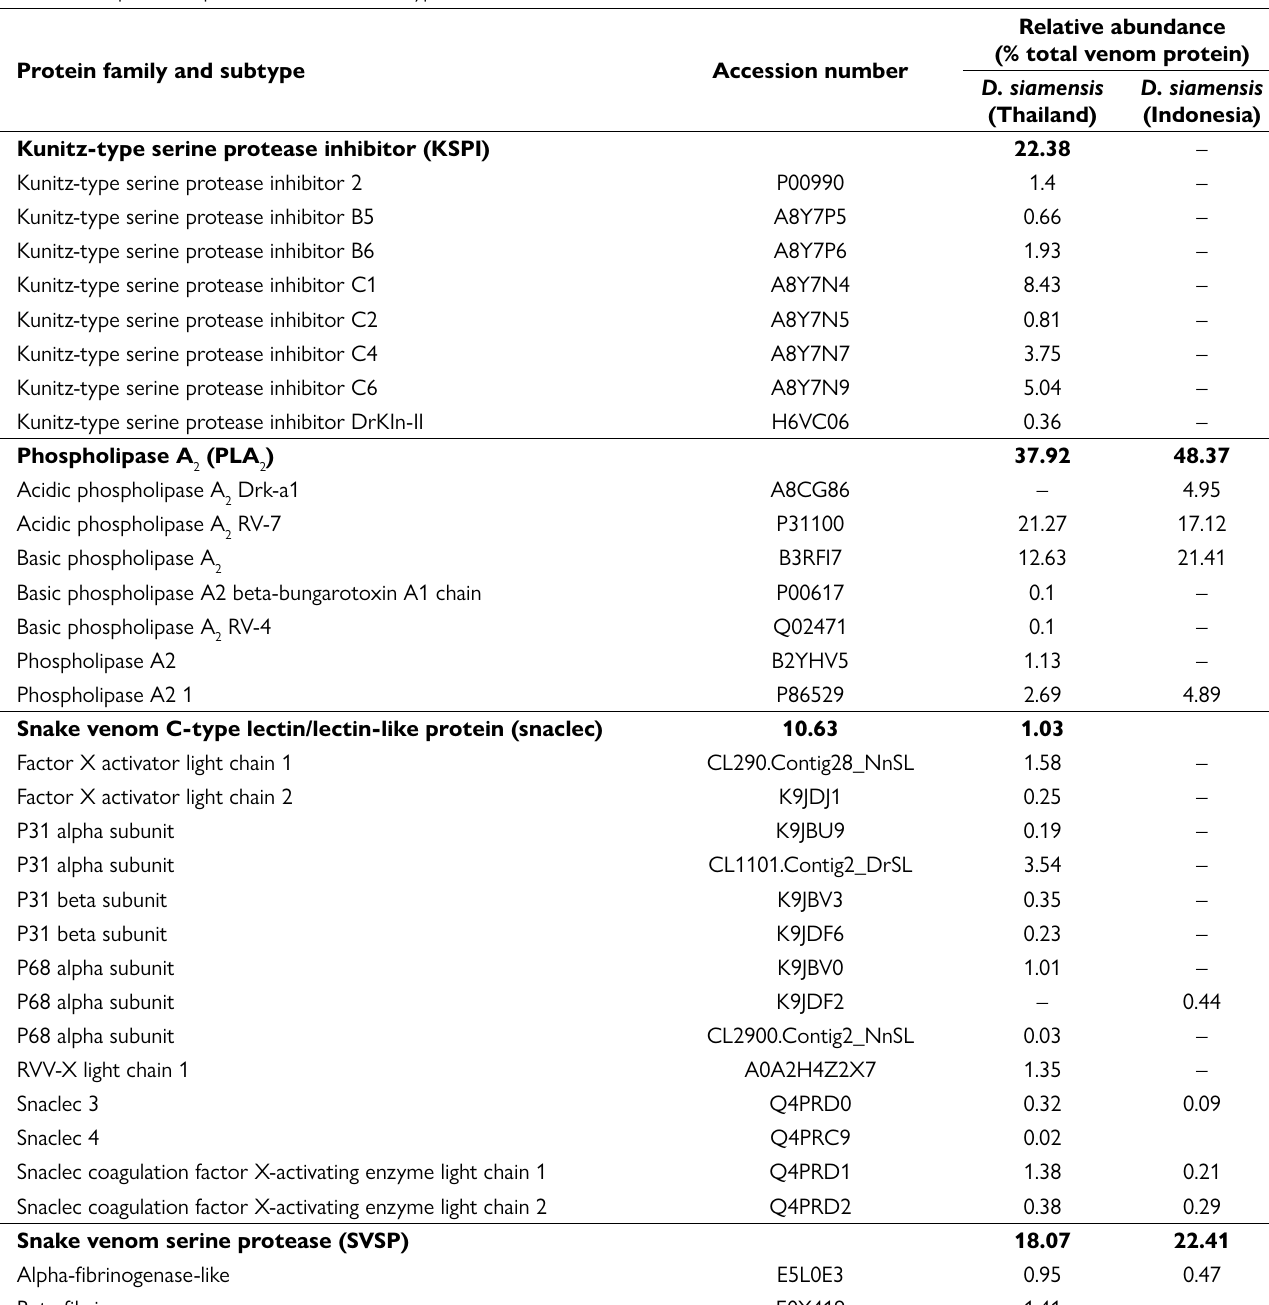
Table 3. Comparison of protein families, toxin subtypes and relative abundances in the venoms of Daboia siamensis from Thailand and Indonesia